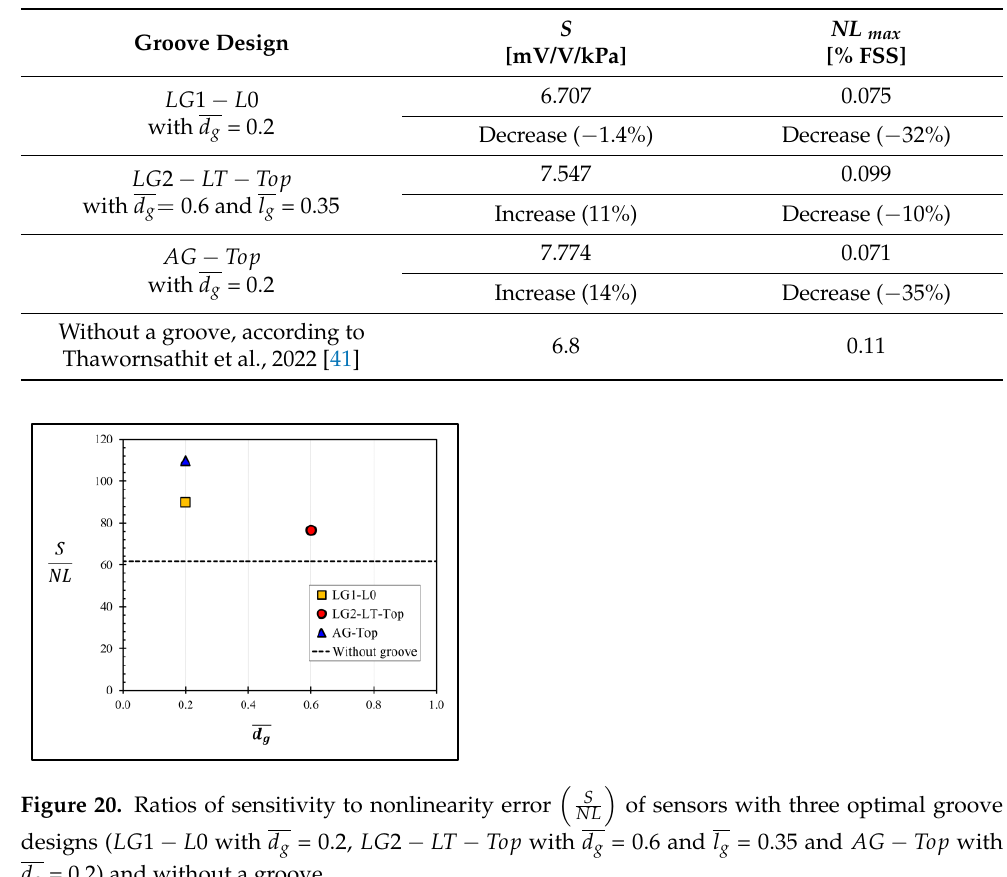
Table 2. Comparisons between sensitivity and nonlinearity of the sensors with three optimal groove designs and those of the sensor without groove.